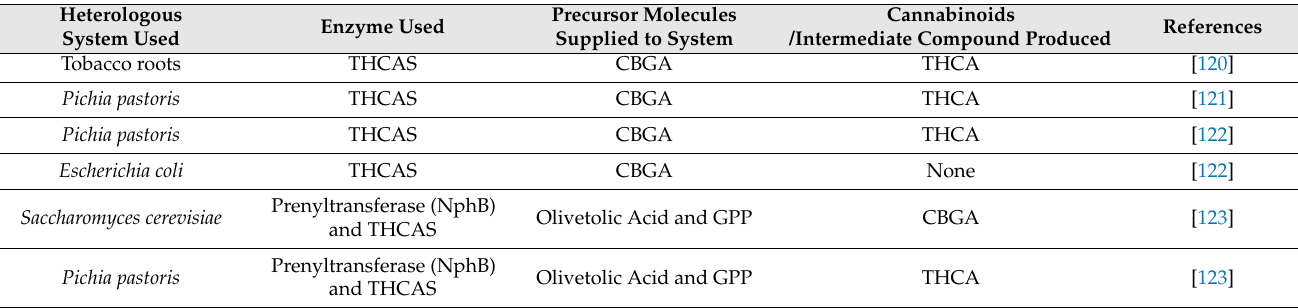
Table 2. Heterologous biosynthesis of phytocannabinoids. Precursor Molecules Cannabinoids Supplied to System /Intermediate Compound